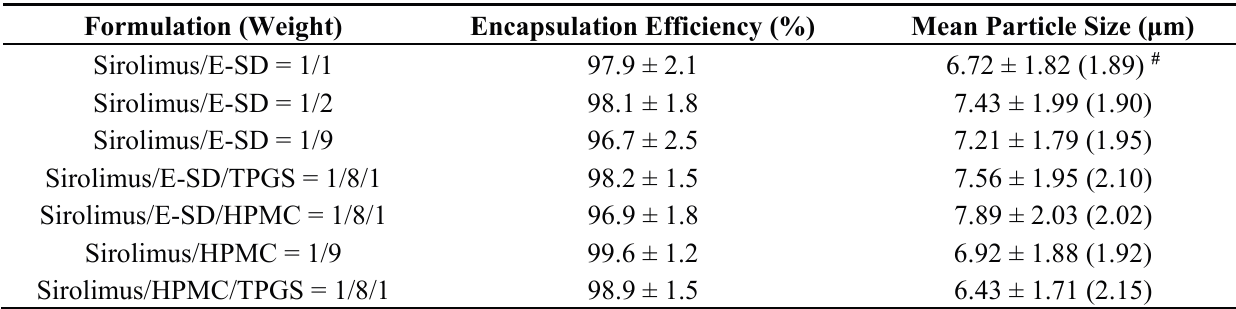
Table 2. Formulation, encapsulation efficiency, and particle size of sirolimus-loaded solid dispersions.